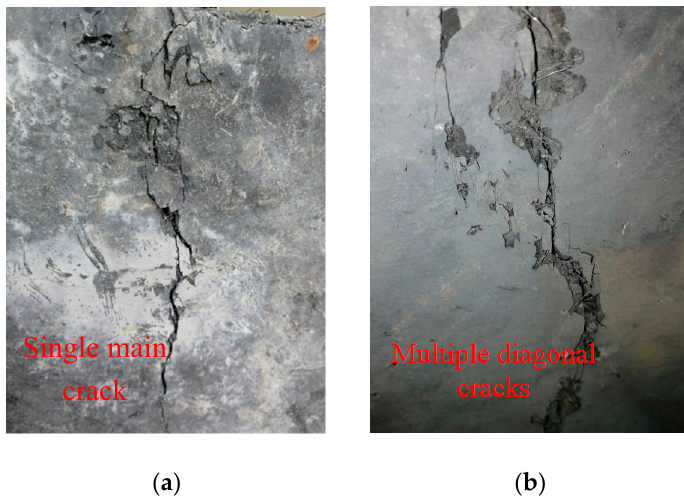
Figure 9. Two typical crack forms: ( a ) single main crack and ( b ) multiple diagonal cracks. Materials 2017 , 10 , x FOR PEER REVIEW